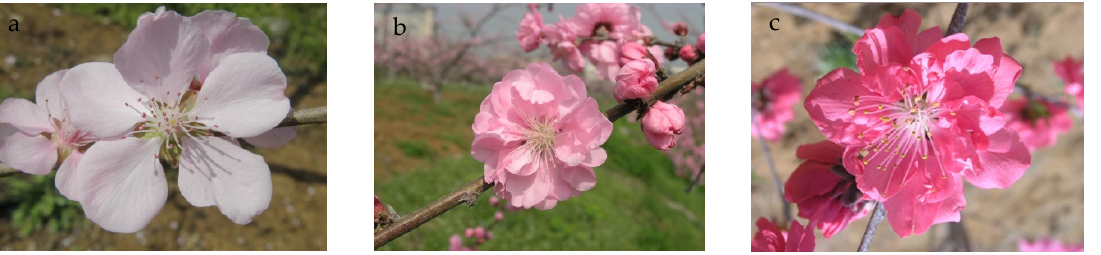
Figure 6. Peach germplasms with special flower aromas. Note: ( a ): ‘Yuntaishanshantao’; ( b ): ‘Hongfenjiaren’; ( c ): ‘Hua3’.